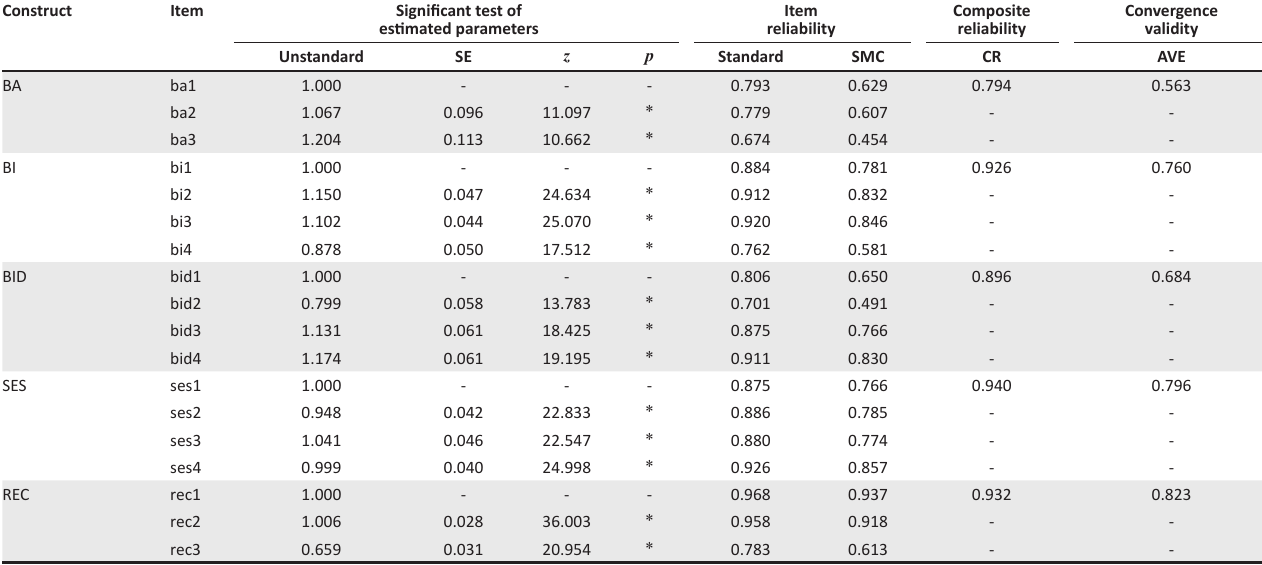
TABLE 1: Confirmatory factor analysis of the measurement model. Construct Item